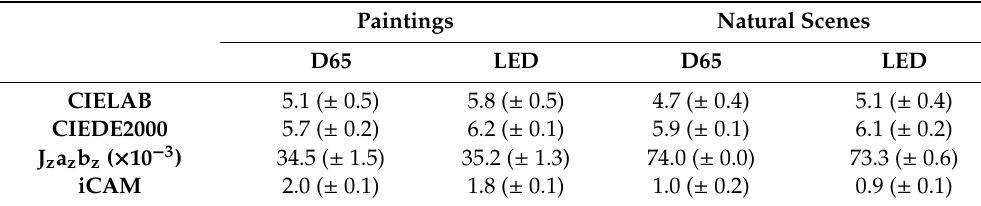
Table 3. Color errors for the color di ff erence formulas and color spaces considered, for CIE D65 and LED illuminants for paintings and natural scenes. Error numbers represent the standard error associated to the